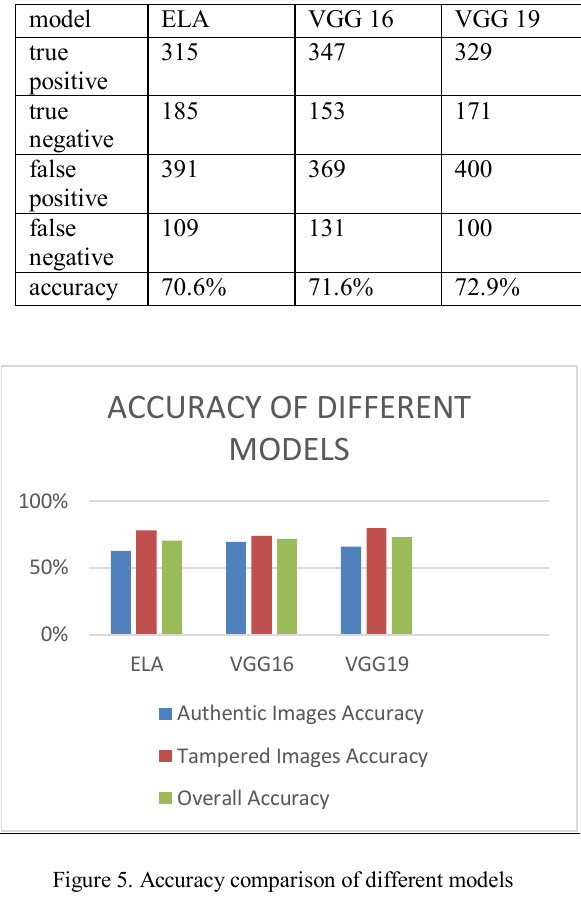
Table 1:Comparison of Different Models